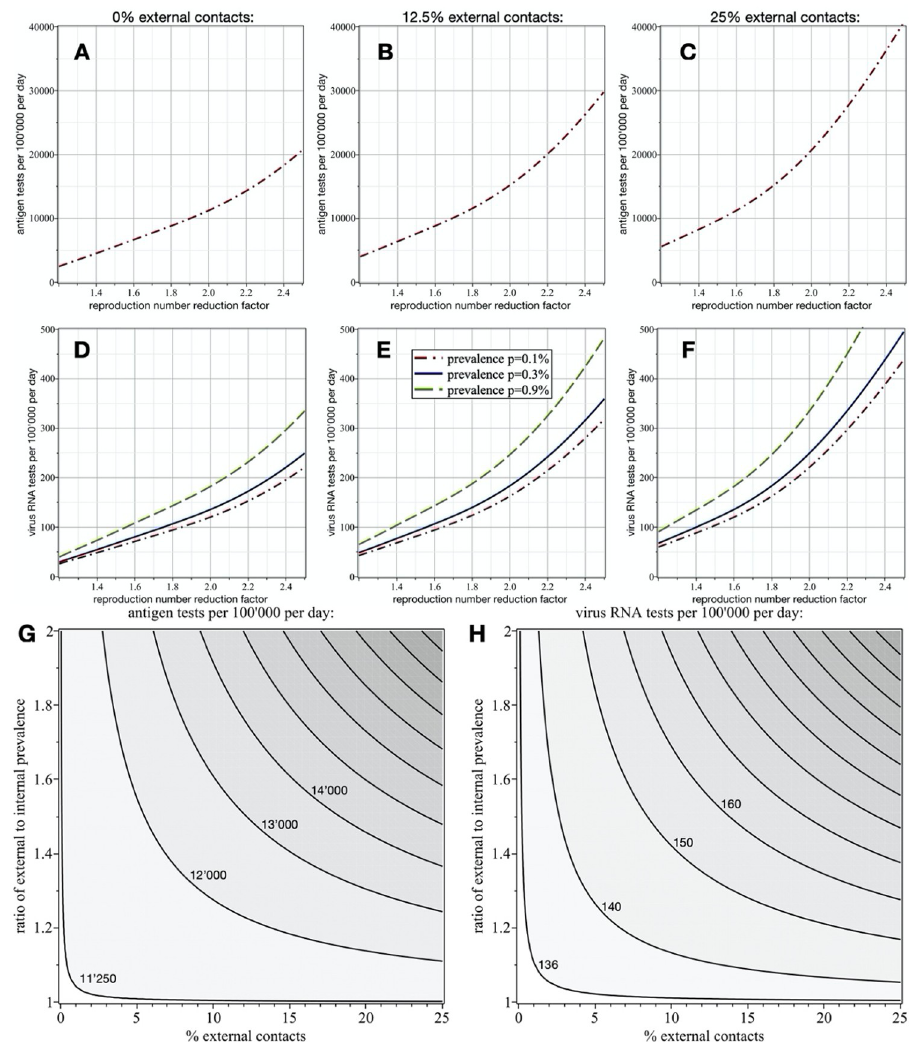
Fig 3. Numbers of required tests per 100’000 people per day as function of reproduction number reduction factor and prevalence p in the undetected population. In the first row (A-C) the number of antigen tests and in the second row (D-F) the number of virus RNA tests are shown. No external contacts are assumed for the results shown in the first column, while 12.5% and 25% external contacts are assumed for the plots in the second and third columns, respectively, where the external population has a two times higher prevalence. As expected, more tests are required to achieve the same reproduction number reduction as the fraction of external infection-relevant contacts increases. Also note that the number of required virus RNA tests increases with a higher overall prevalence (D-F), while the number of antigen tests is independent of p (A-C). Also shown are the effects of fraction of external contacts and ratio of external to internal prevalence on the numbers of required antigen (G) and RNA tests (H) per 100’000 people per day to reduce the reproduction number by a factor of two. A 95% sensitivity and one day delay is assumed for the virus RNA tests, and for the antigen tests sensitivity and specificity of 70% and 99% are